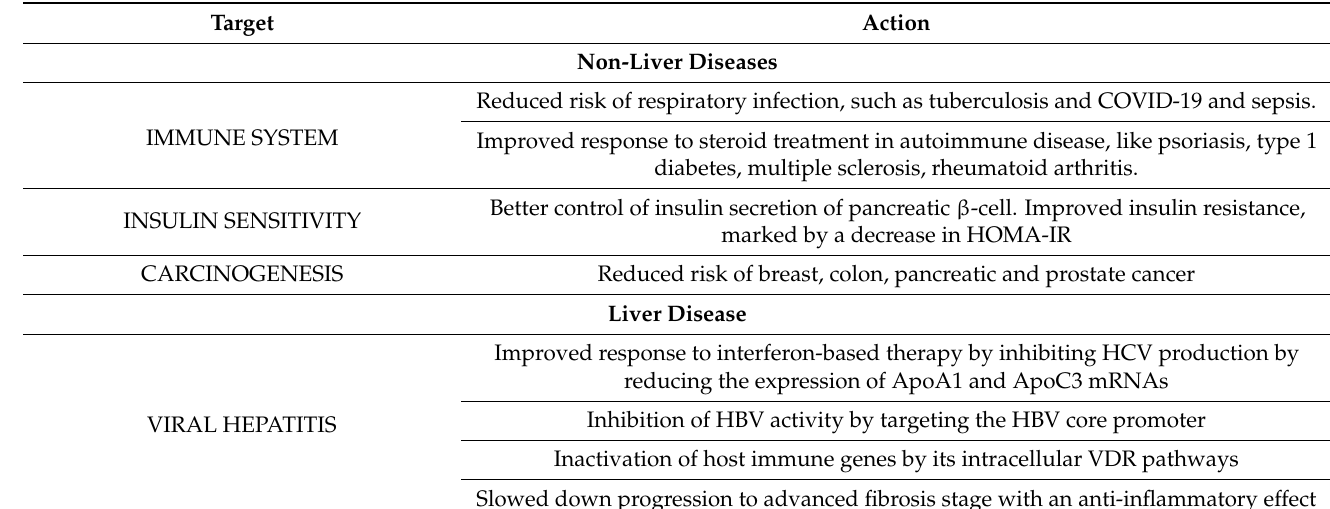
Table 1. Impact of vitamin D supplementation in liver and non-liver diseases 1 (HOMA-IR: Home- ostasis Model Assessment Insulin Resistance; HCV: hepatitis C virus; ApoA1: Apolipoprotein A1; ApoC3: apolipoprotein C-III; HBV: hepatitis B virus; VDR: vitamin D receptor; NAFLD: non-alcoholic fatty liver disease; ALD: alcoholic liver disease; TNF: tumour necrosis factor; AIH: autoimmune hepatitis; Th: T helper; PBC: primary biliary cholangitis; SBP: spontaneous bacterial